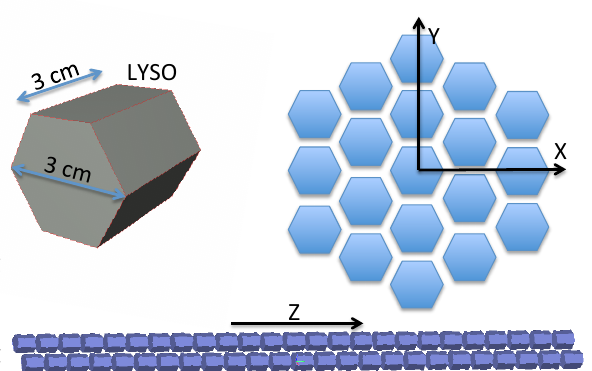
Figure 12. Top left: rendering of the LYSO crystal hexagonal prism shape. Top right: placement of LYSO crystals in the honeycomb layout projected on the X–Y plane. A gap up to 8mm between crystals has been used as optimal compromise to maximize the detector acceptance while keeping a limited mass budget and without largely impacting the energy resolution for laterally narrow showers. Bottom: placement of LYSO crystals along the longitudinal axis of the calorimeter. Crystals with the same X coordinate are staggered by half-length to avoid dead spaces. Figure readapted from[96] under license CC BY